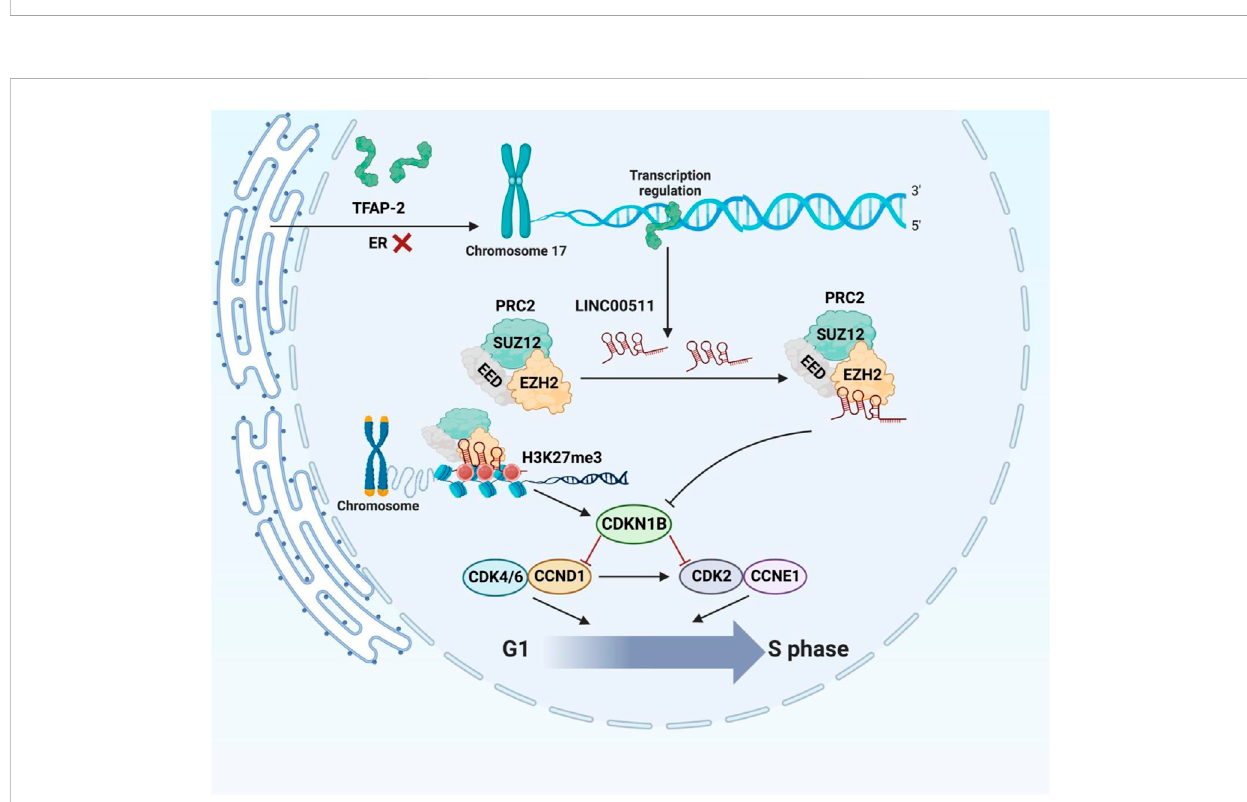
FIGURE 2 The carcinogenic role of LINC00511 in ER-negative tumorigenesis. ER insuf fi ciency enhanced TFAP-2 activity at particular promoter regions, promoting LINC00511 expression. By interacting with EZH2 to attract PRC2 to regulate histone methylation, the ER-negative-associated LINC00511 repressed the expression of CDKN1B, assisting in the G1/S transition to maintain cellular